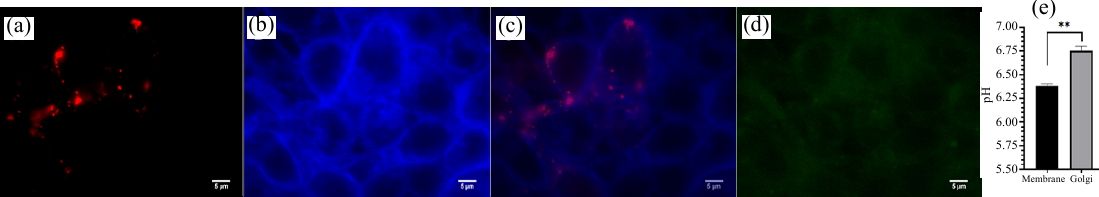
Fig. 11 Fluorescent microscope images of HEK cells transfected with Golgi targeted mCh. and treated with 50 µM ThiAKS Green: (a) mCh. channel, (b) DAPI channel, (c) overlay of (a) and (b), (d) image from EGFP channel, and (e) calculated pH from ratio EGFP/DAPI intensities of membrane and Golgi (Magnification 100X, scale bars are 5